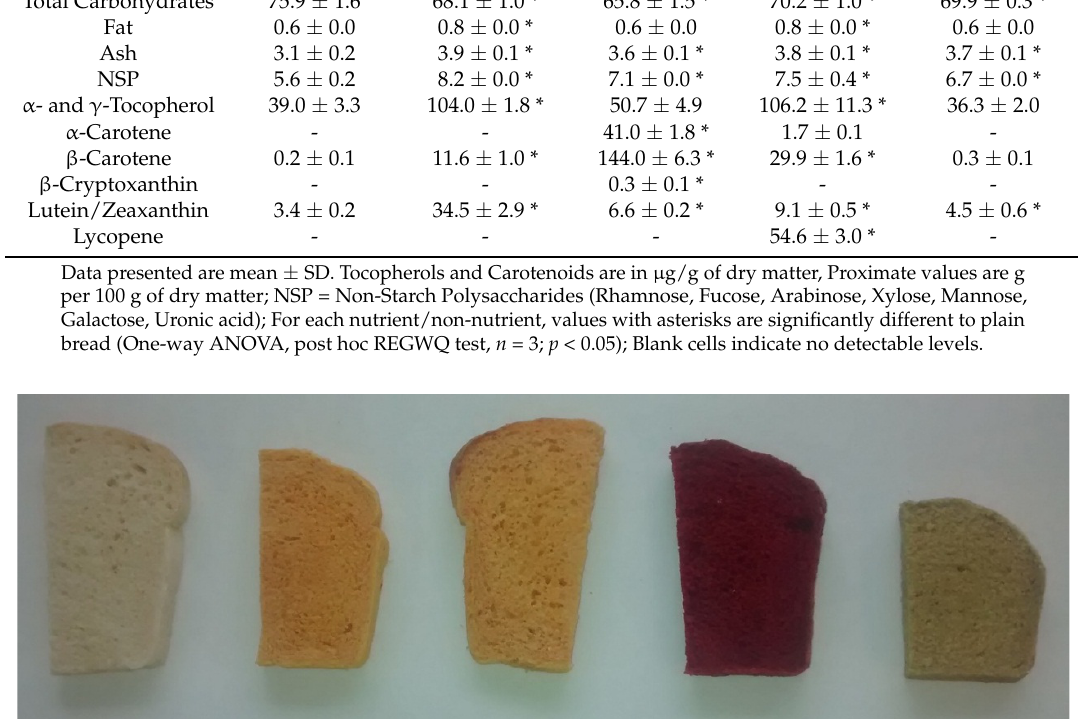
Figure 1. Bread samples showing transverse structure and loaf size. From Left to right: Plain bread, Carrot bread, Tomato bread, Beetroot bread, Broccoli bread.